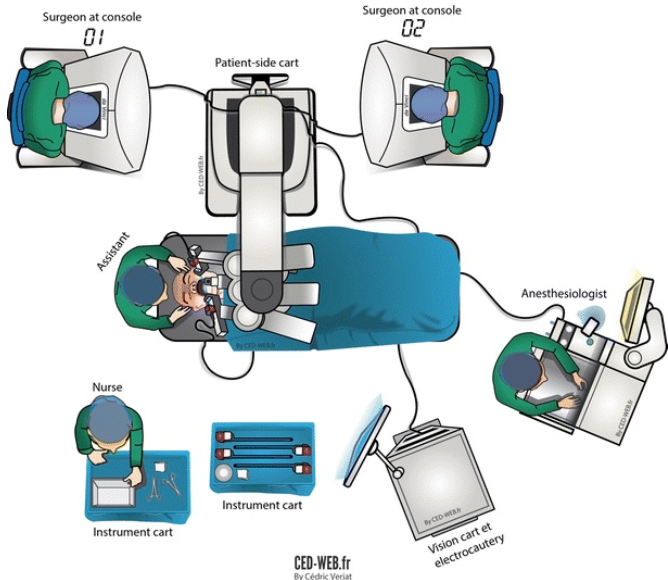
Figure 3. From Gorphe et al. (2017) [15]. Diagram of the operating room.